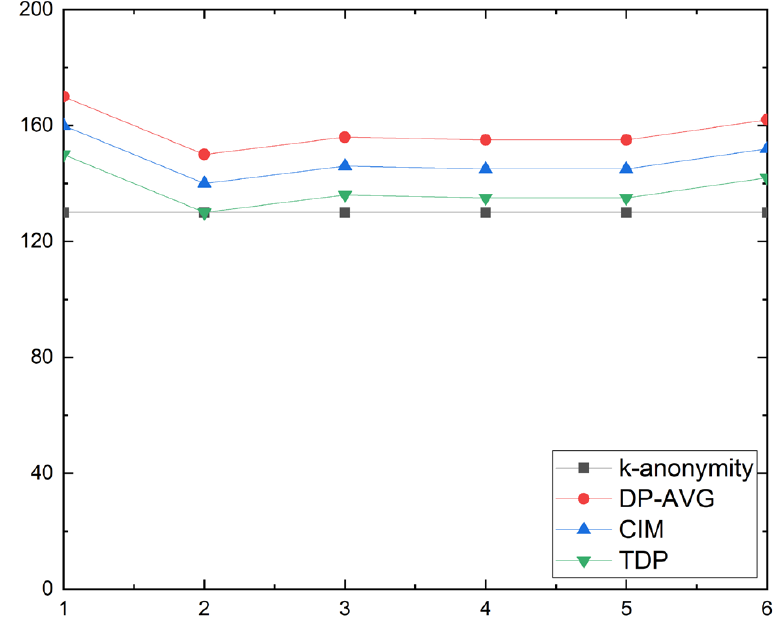
Figure 7. MSE comparison diagram for T-drive Taxi Trajectories dataset.